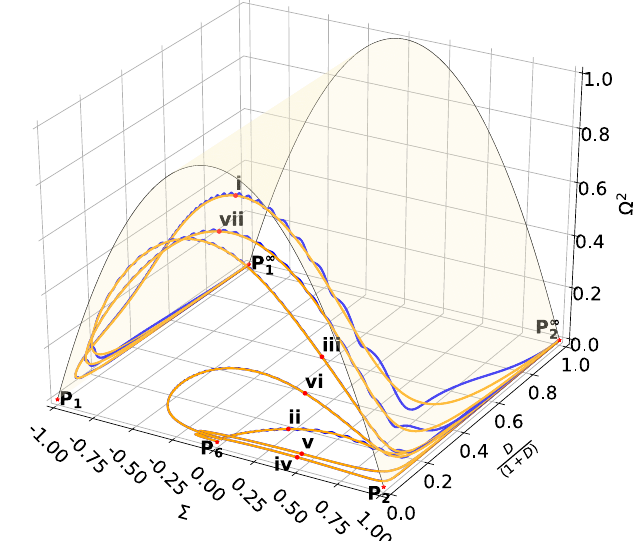
Fig. 13 Some solutions of the full system (93) (blue) and time-averaged system (127) (orange) for the KS metric when γ = 0 in the projection Q = 0.